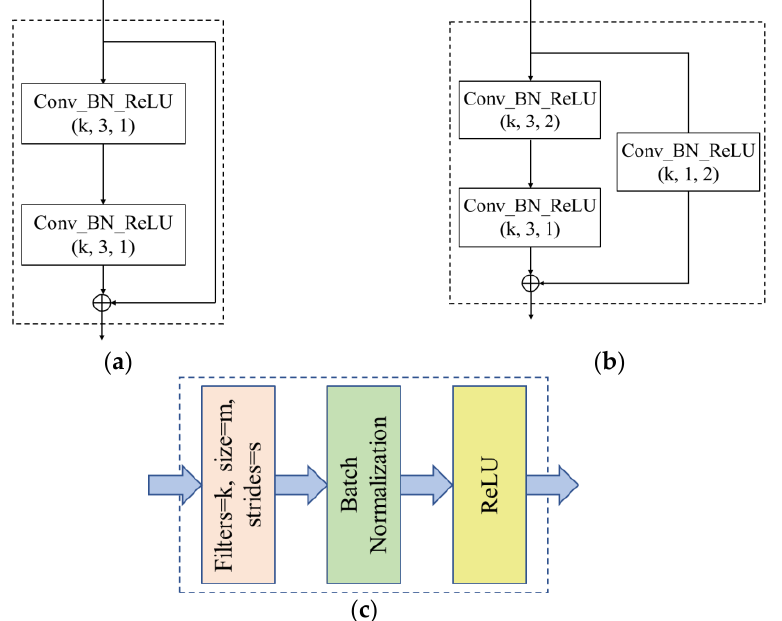
Figure 7. Two types of residual block used in TongueCaps. ( a ) Residual Block_a; ( b ) Residual Block_b; ( c ) Conv_BN_ReLU (k, m, s). The difference between residual blocks_a and b is whether